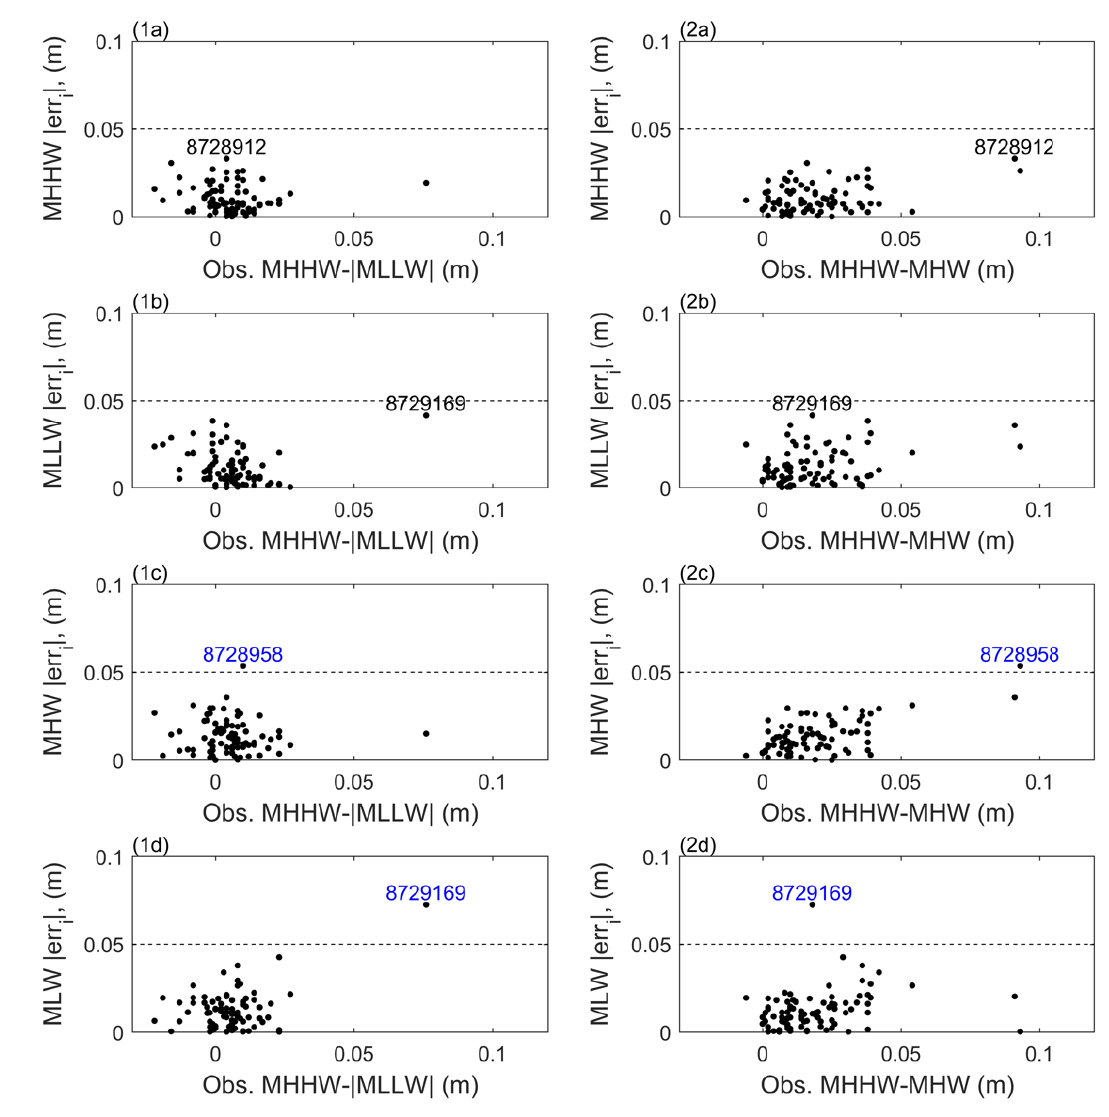
Figure 8. Model errors for ( a ) MHHW, ( b ) MLLW, ( c ) MHW, and ( d ) MLW versus observed differences in magnitude of ( 1 ) MHHW and MLLW, and ( 2 ) MHHW and MHW for stations in the VDatum region.